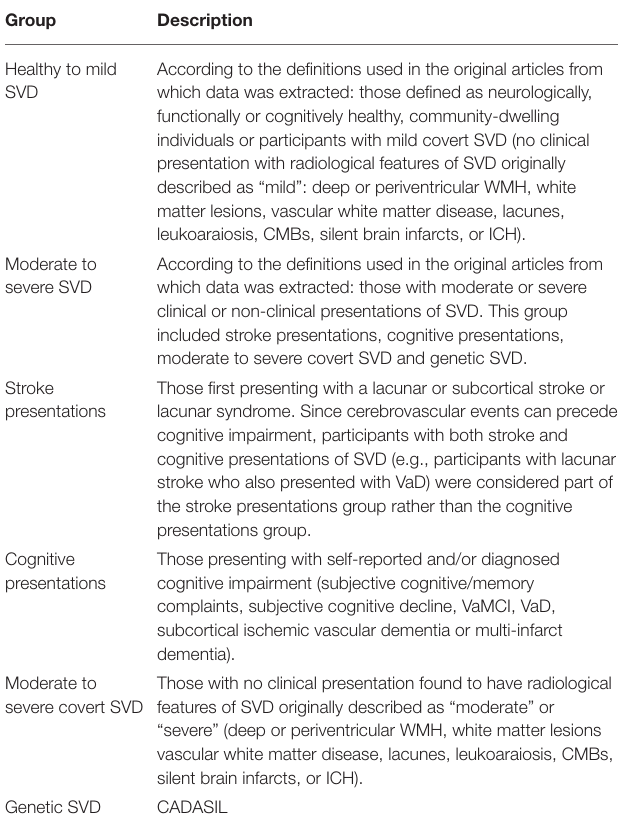
TABLE 2 | Study classification by SVD severity and